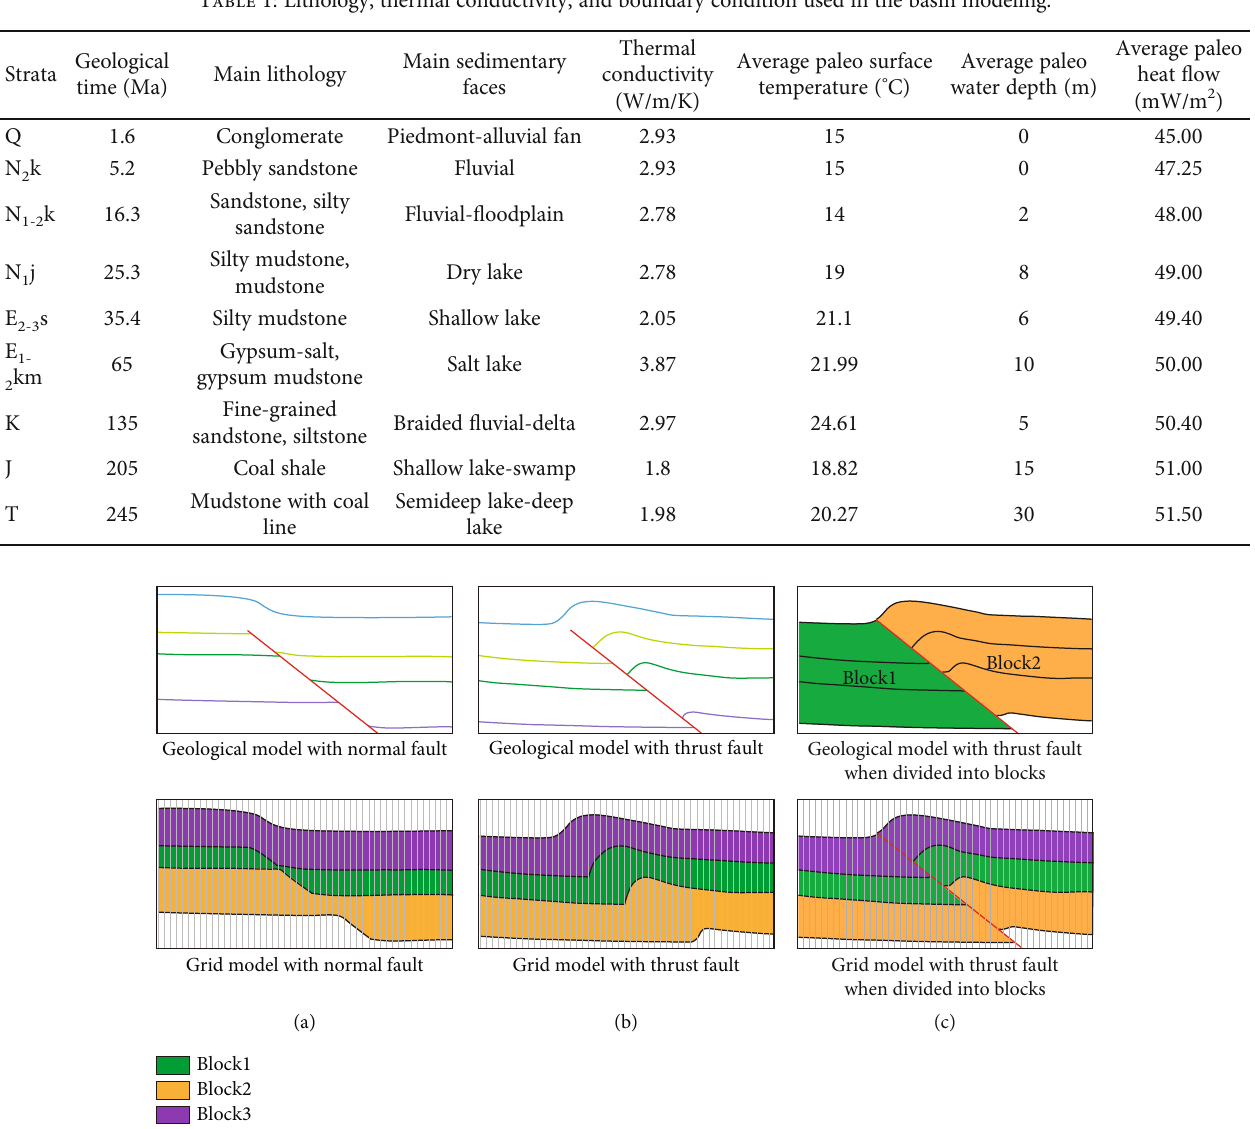
Figure 3: Comparison of geological models and grid models with normal or thrust